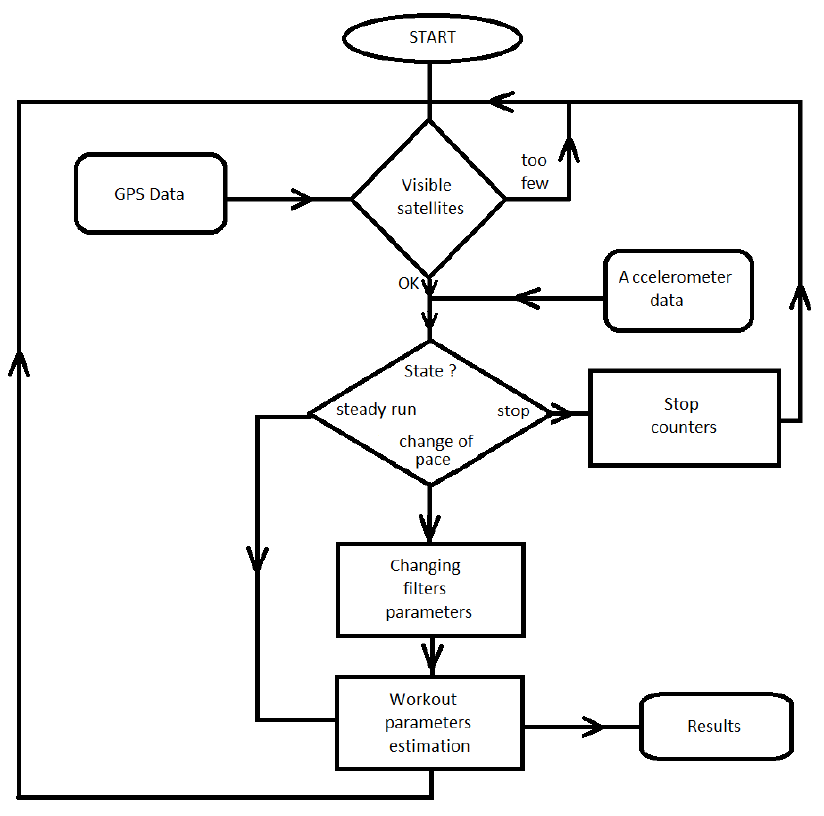
Figure 4. Functional diagram of the system for estimation of running parameters.